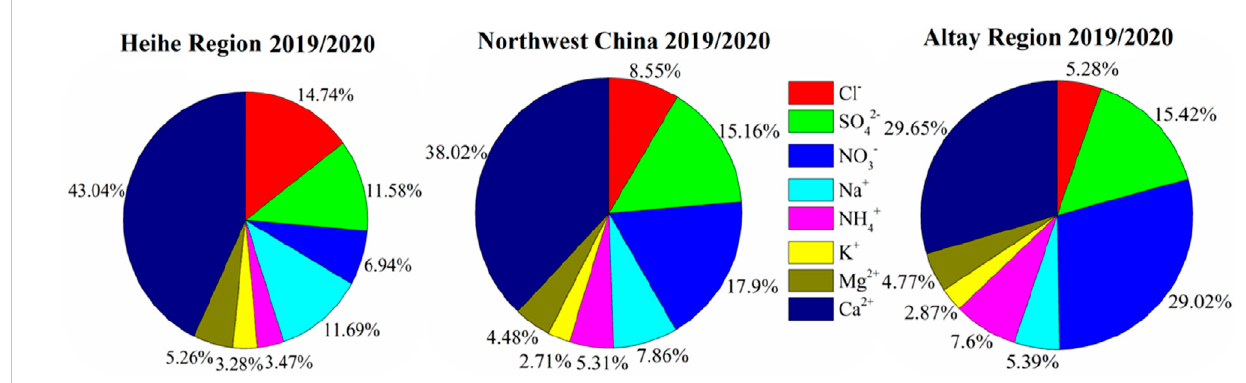
FIGURE 3 The proportion of ion concentration in Heihe region, Altay region and Northwest China region in 2019/2020.